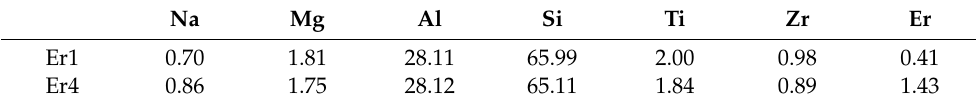
Table 1. Compositional analysis in at% of the Er-doped samples manufactured in an oxygen atmosphere.